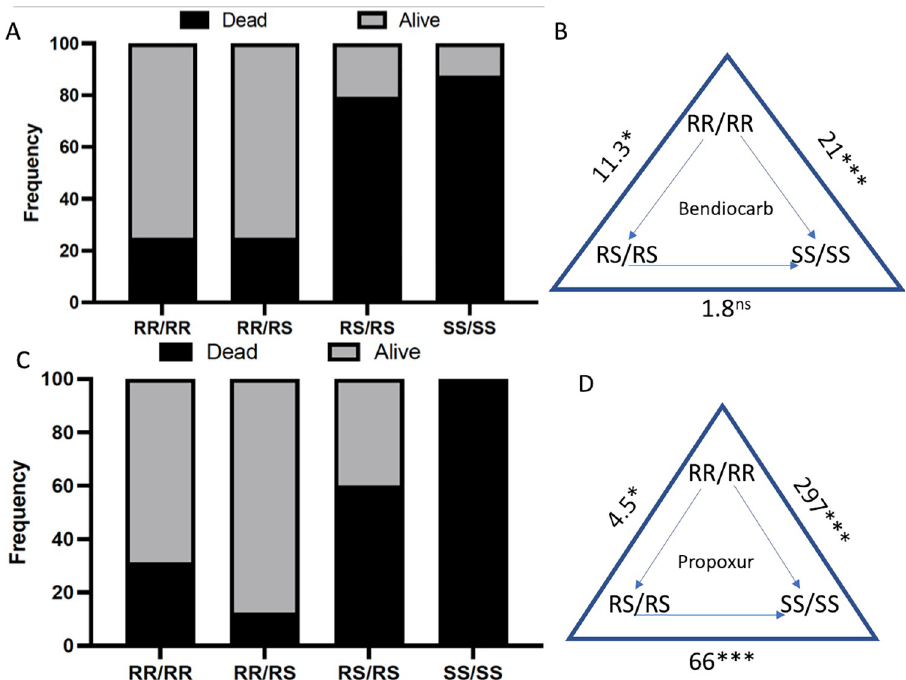
Fig 5. Combined effect of the 6.5kb insertion and CYP6P9a on carbamate resistance. A) Distribution of combined genotypes between bendiocarb resistant and susceptible An . funestus showing that genotypes at both loci combined to additively increase the ability to survive after exposure to bendiocarb. B) Double homozygote resistant An . Funestus are significantly more likely to survive exposure to bendiocarb than double homozygote susceptible (SS) (Odds ratio 21; P < 0.001) and than heterozygotes (Odds ratio 11.3; P < 0.01). C and D) are for propoxur respectively.